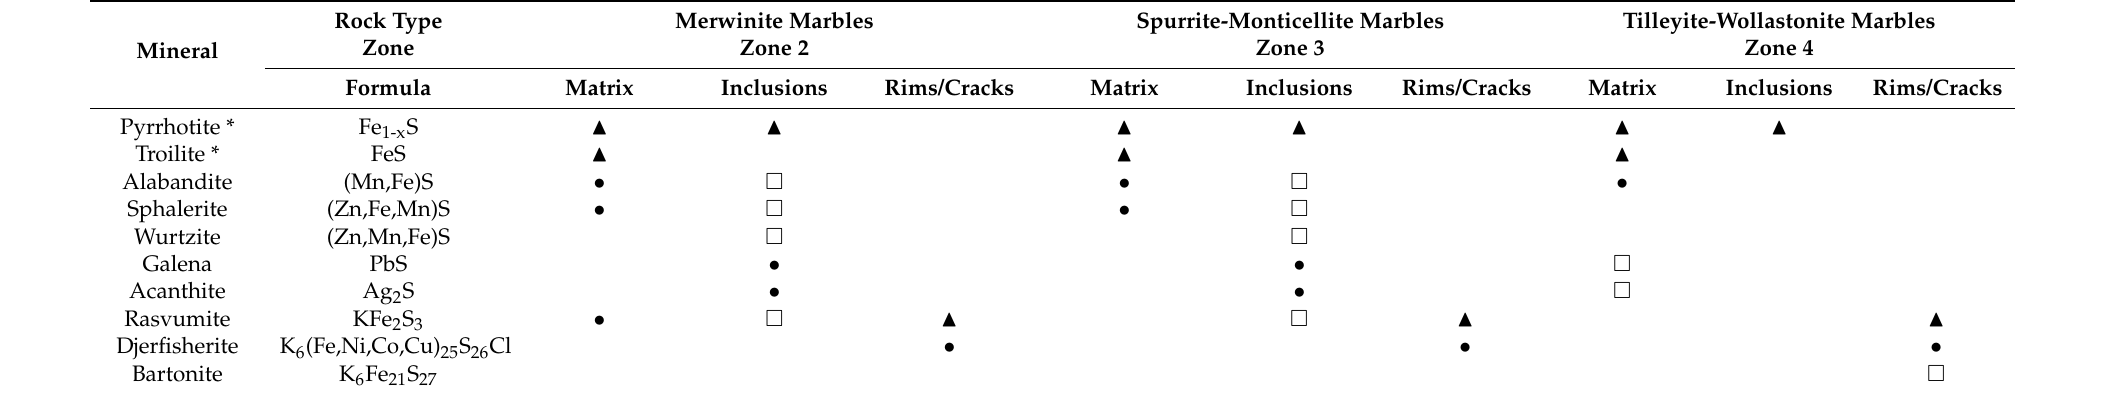
Table 5. Sulfide minerals found in marbles from the Kochumdek contact